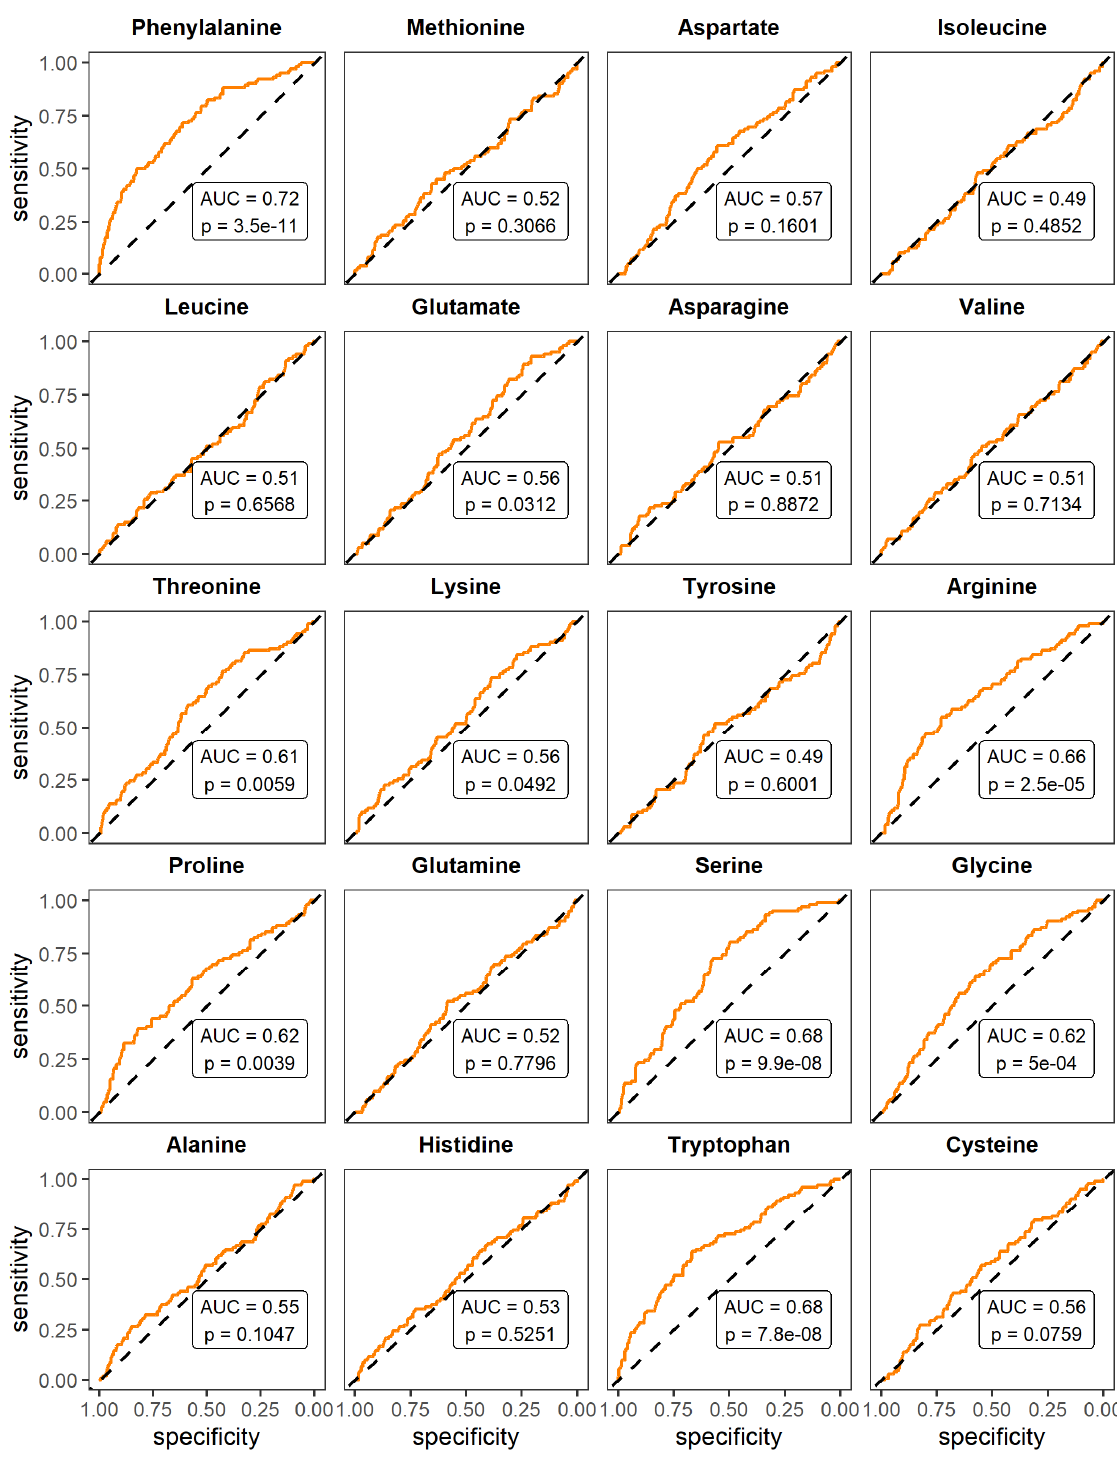
Figure 3. Ability of circulating-amino-acid levels to predict adverse outcomes (intensive-care-unit admission or hospital death). Univariate logistic regressions were used, and areas under the